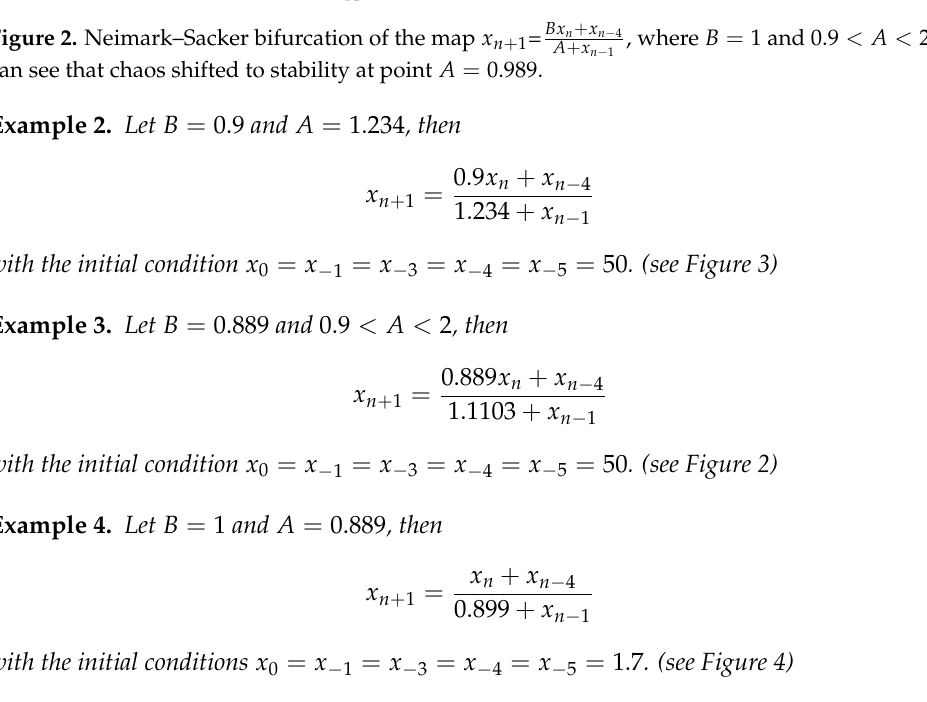
, where B = 1 and 0.9 < A < 2, we A + x n − 1